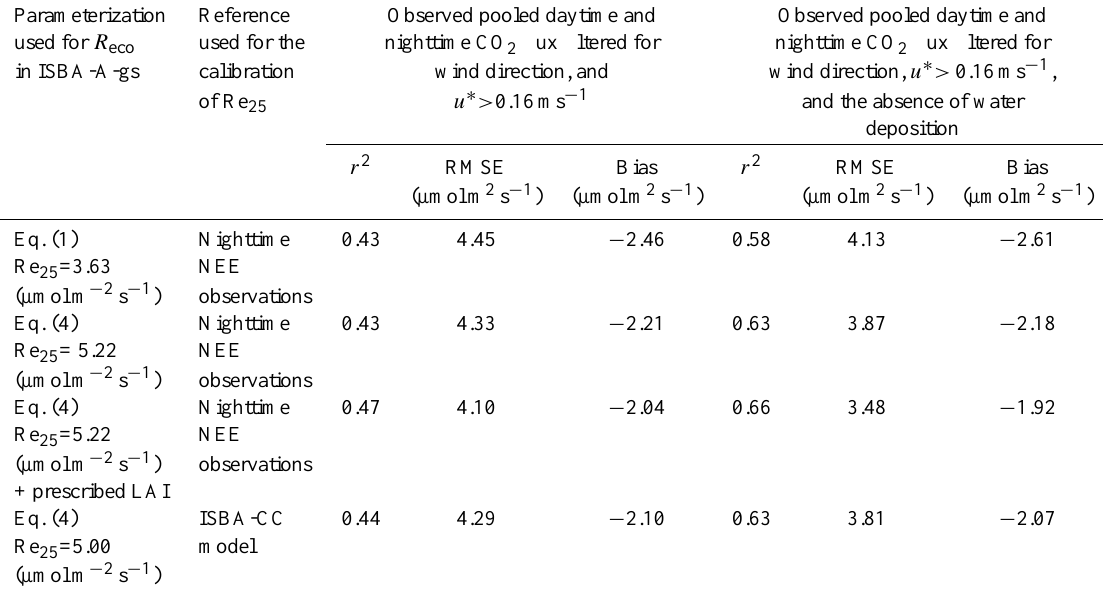
Table 3. Comparison between observed and modelled (ISBA-A-gs) NEE using either Eq. (1) or Eq. (4). The modelled NEE is compared with NEE observations, with and without filtering for water deposition.